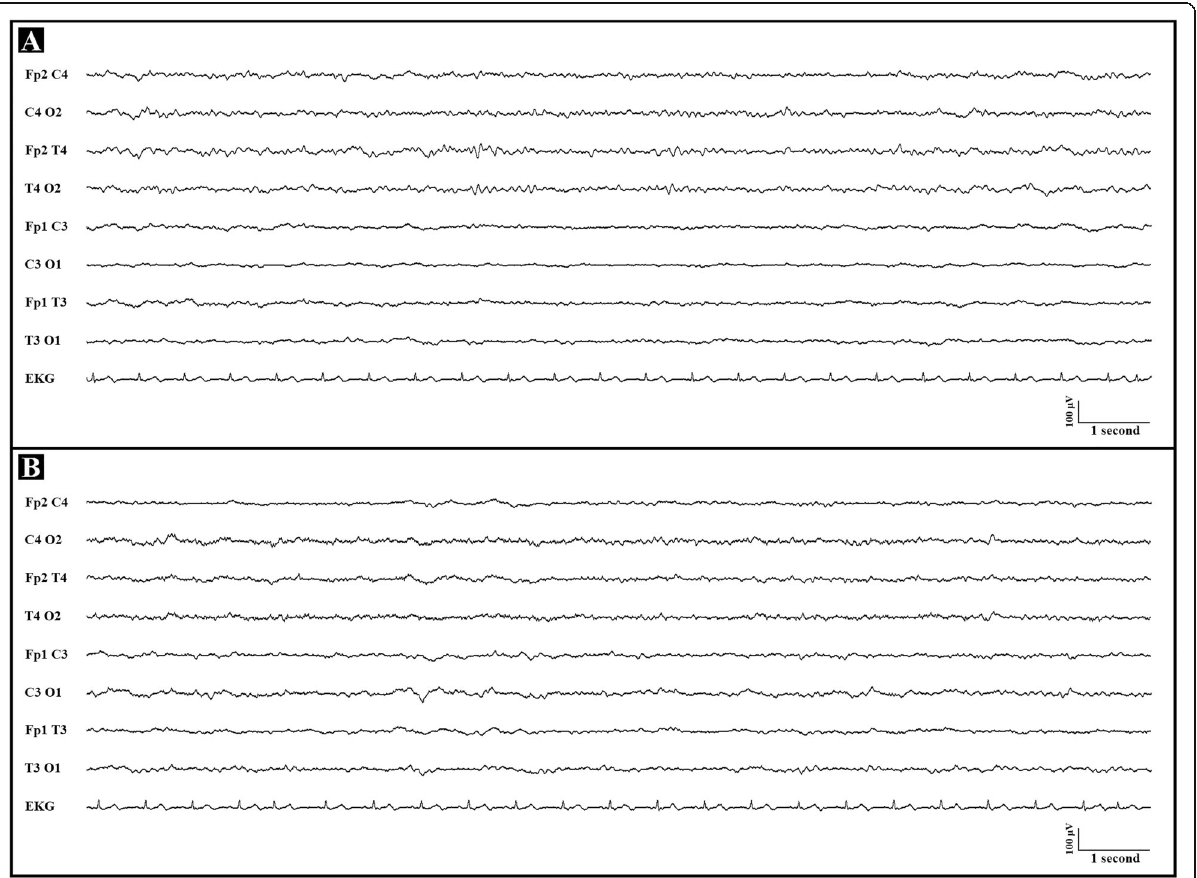
Fig. 2 Electroencephalogram findings. Panel A : fifteen seconds of ictal EEG: clear amplitude asymmetry of background activity consisting in diffuse depression in left hemispheric fields without epileptiform abnormalities. Panel B : fifteen seconds of normal interictal